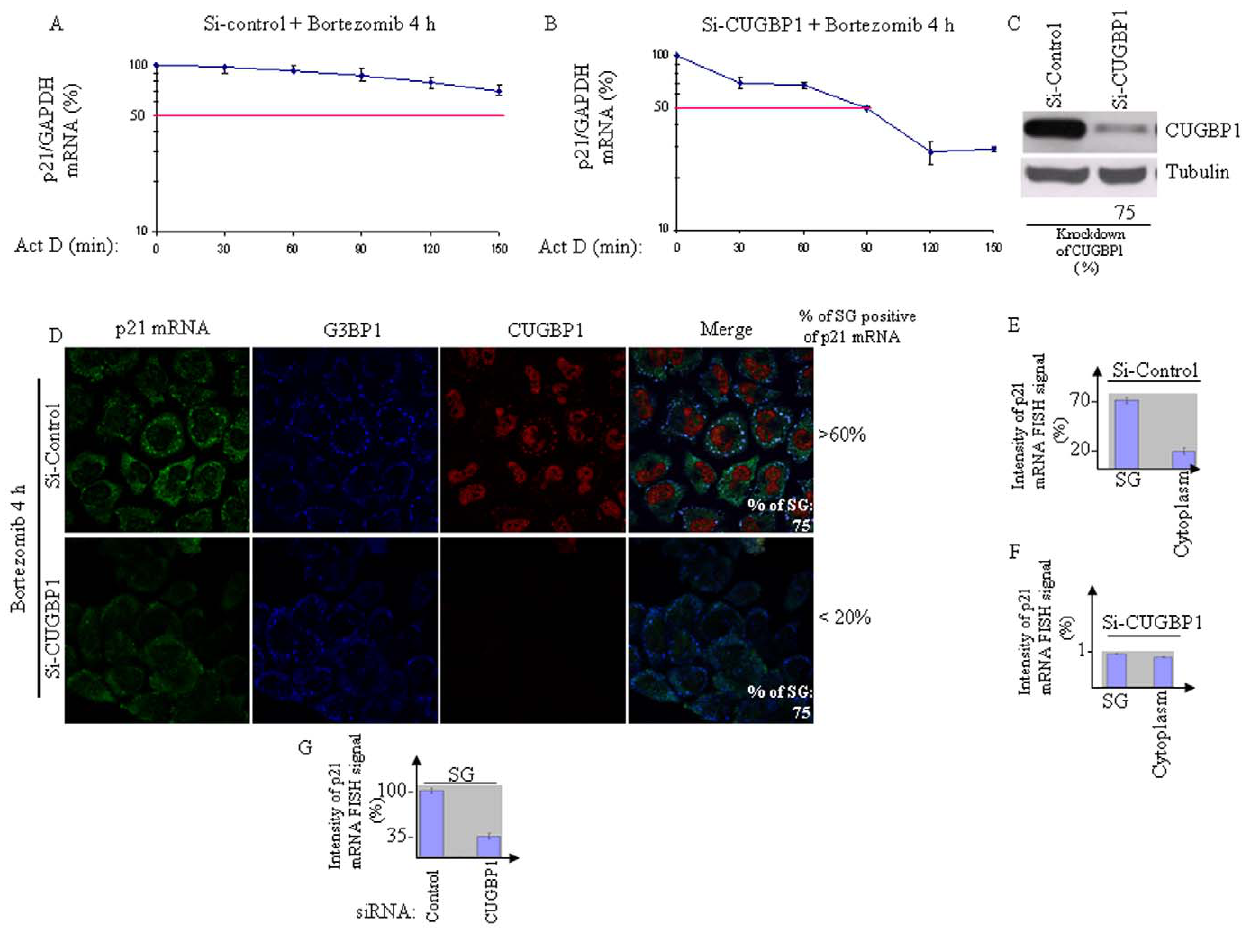
Figure 4. Reducing CUGBP1 levels prevents bortezomib-mediated p21 mRNA stabilization and accumulation in SG. (A–B) HeLa cells were treated with non-specific (A), or with CUGBP1-directed siRNA (B), incubated with bortezomib (2 m M) for 4 h, and actinomycin D (5 m g/ml) was